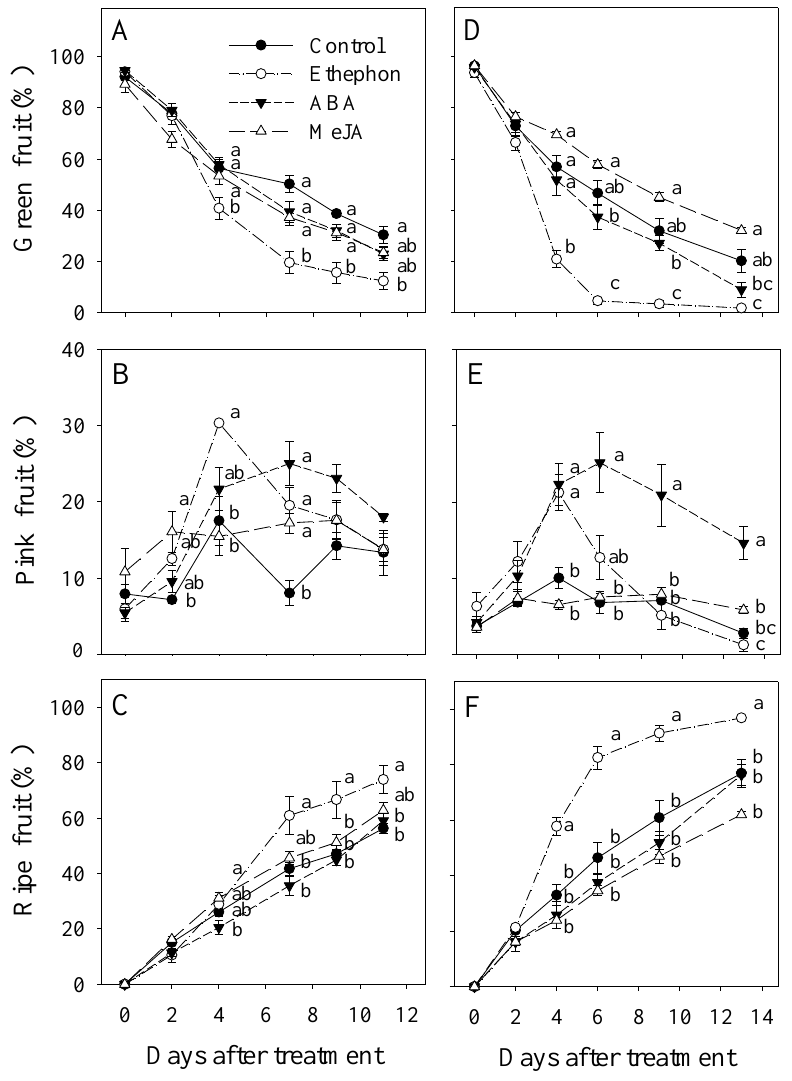
Figure 1. Effect of preharvest treatments with water (contol), ethephon, abscisic acid (ABA), and methyl jasmonate (MeJA) on ripening of rabbiteye blueberry, Premier ( A – C ) and Powderblue ( D – F ). Values are means and standard errors of four replicates. Within each assessment period, means with the same letter are not significantly different according to ANOVA and Tukey’s HSD (α = 0.05).